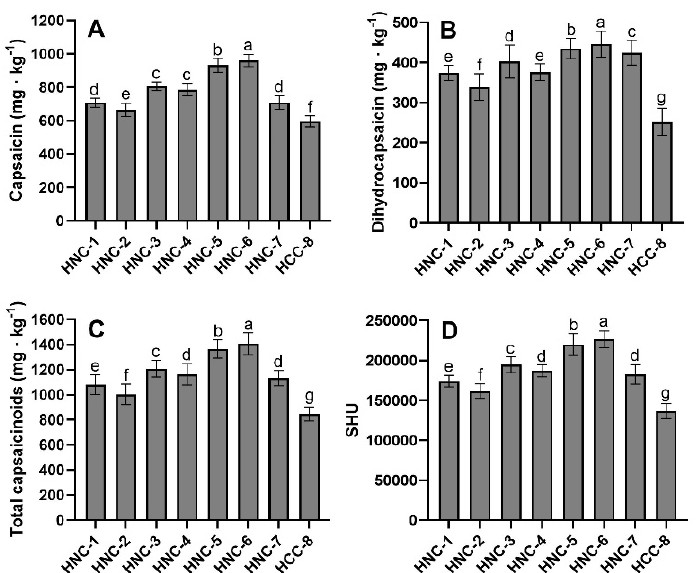
Figure 3. Content of capsaicin ( A ), dihydrocapsaicin ( B ), total capsaicinoids, ( C ) and Scoville Heat Units SHU ( D ) in fruits of eight genotypes of habanero pepper grown in the southeast of Coahuila. Values are the average of four replications. Means ( n = 4). Bars represent the standard deviation of the mean. Different letters in each bar mean that the genotypes were statistically different (Tukey, p ≤ 0.05).